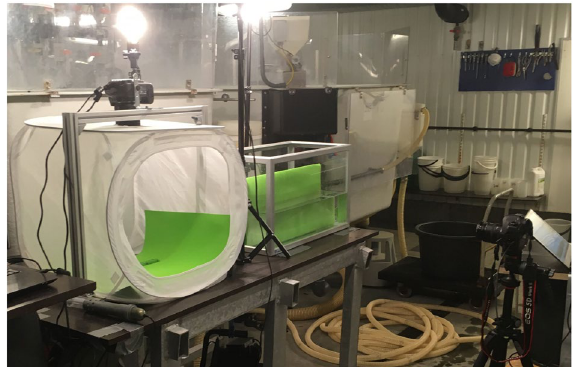
Figure 1. Experimental setup for data collection. Photo tent with camera installed on top, aquarium with the camera installed in front of it, and LED lights for scene illumination. The green background was installed in the tent and